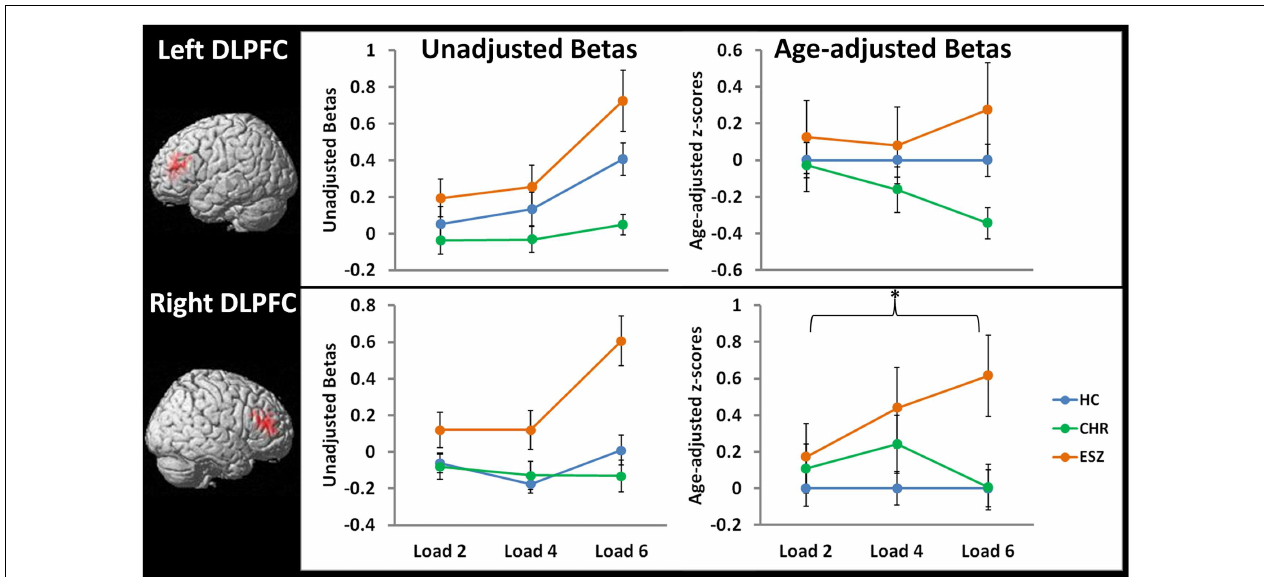
FIGURE 5 | Line graphs display mean fMRI contrast value ( ± standard error) for left and right DLPFC regions-of-interest by Group, for low (two-item), medium (four-item), and high (six-item) working memory loads during the probe condition. Unadjusted (left) and age-adjusted (right) data are shown in figure